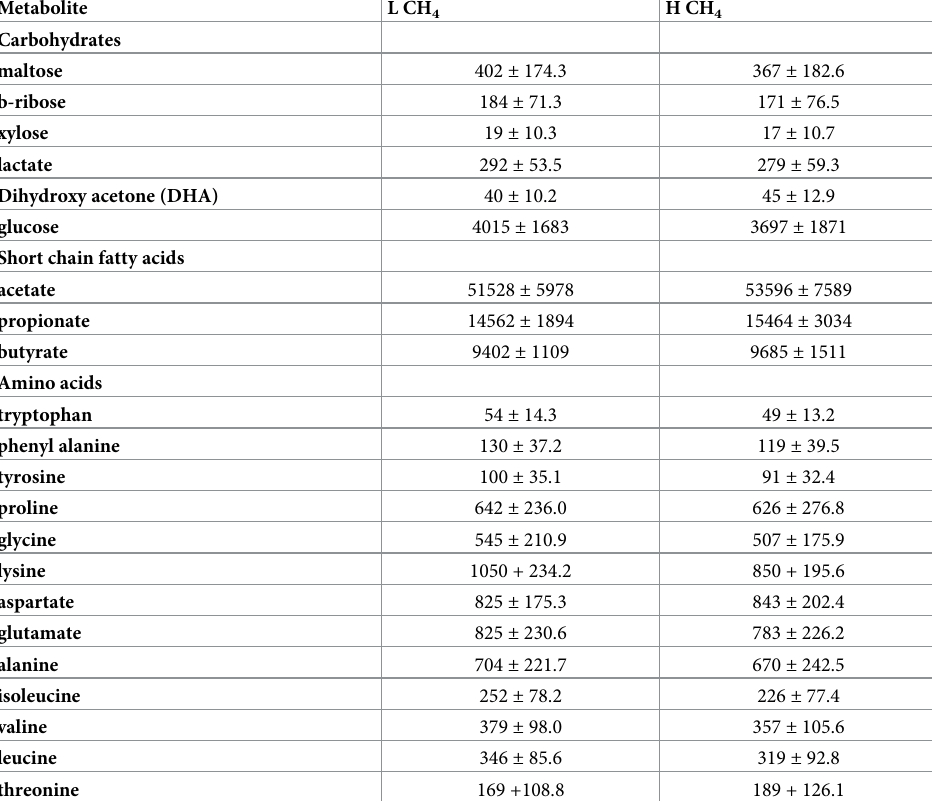
Table 3. Metabolites concentration ( μ M) quantified using NMR in rumen fluid collected post-mortem approxi- mately 3 h after feeding in L or H CH 4 emitting sheep (n = 10/ CH 4 group, mean ± standard deviation). P > 0.05 (ns) for all measures in the table.